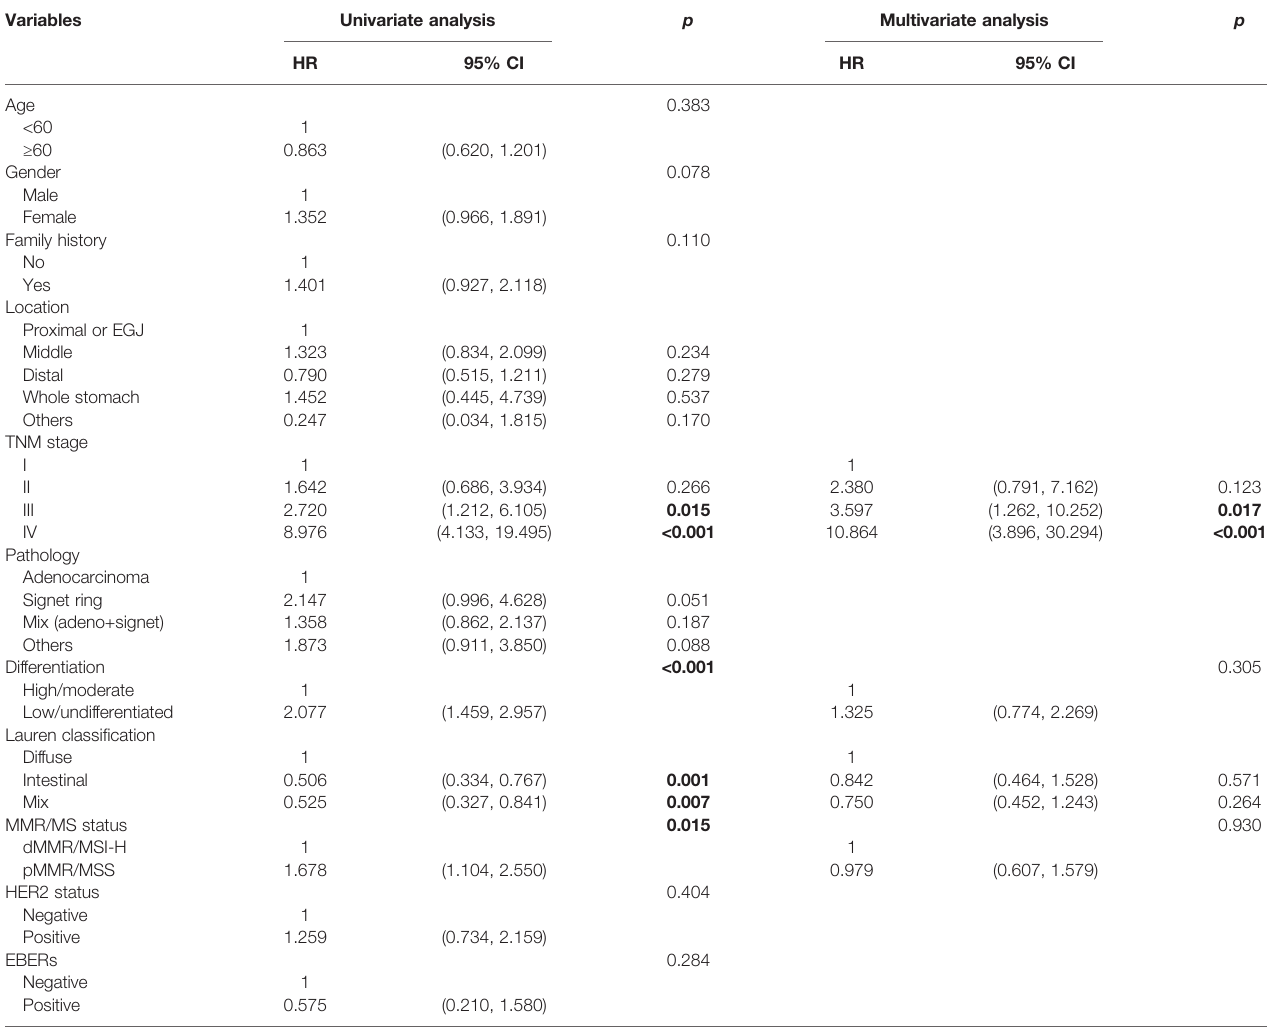
TABLE 3 | Univariable and multivariable Cox proportional hazard models for overall survival.